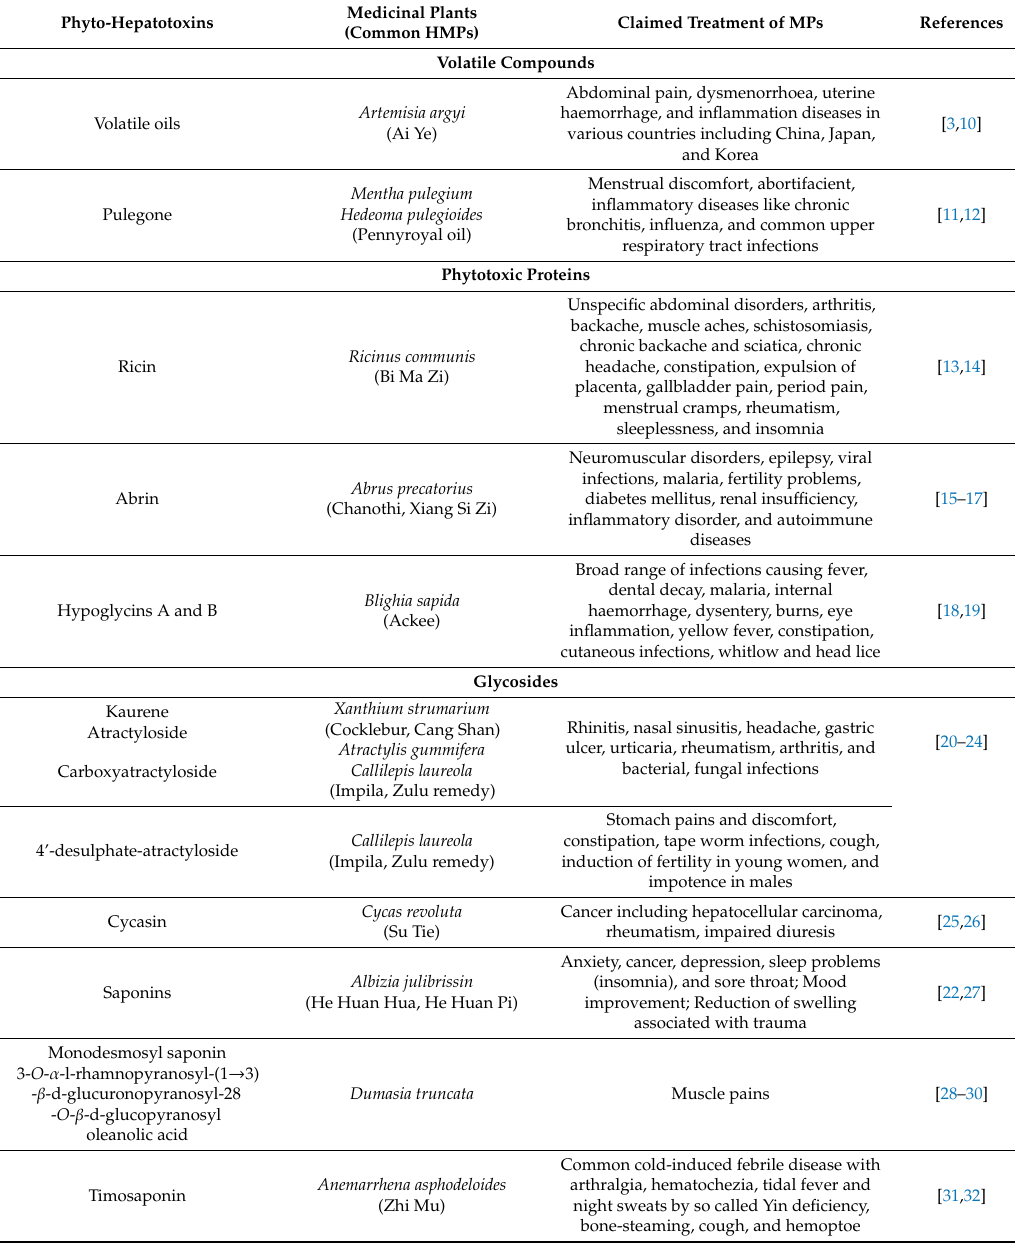
Table 1. List of phyto-hepatotoxins found in herbal medicinal